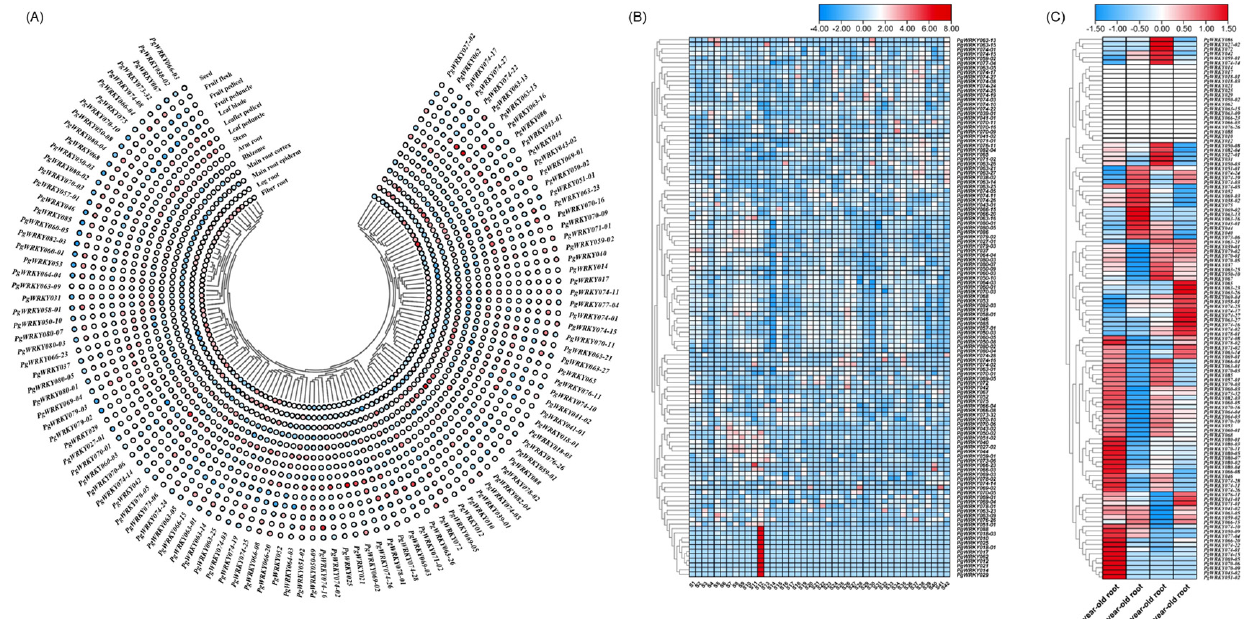
Figure 7. Expression heatmaps of the PgWRKY gene family transcripts in Panax ginseng . ( A ) The 118 PgWRKY genes expressed in the 14 tissue of 4 years old ginseng. ( B ) The 118 PgWRKY genes expressed in the 42 farmers’ cultivars of ginseng. ( C ) The 118 PgWRKY genes expressed in the 4 different aged roots.